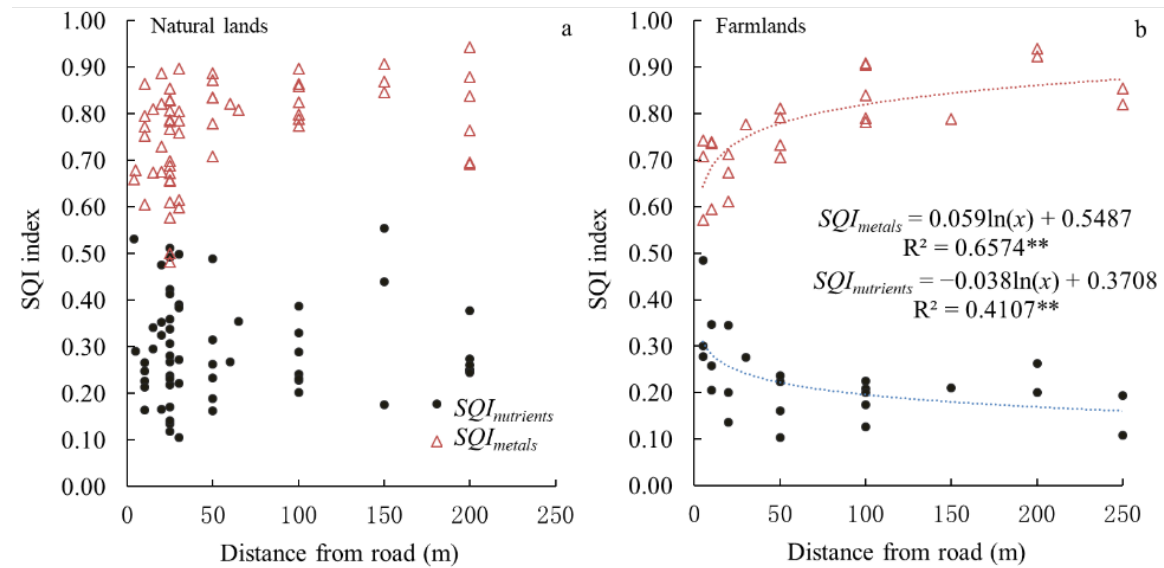
Figure 2. The changes of SQI index for soil nutrients and heavy metals with distance to road in natural lands and farmlands. ( a ): SQI index in the natural lands; ( b ): SQI index in the farmlands. **: the correlation is very significant.